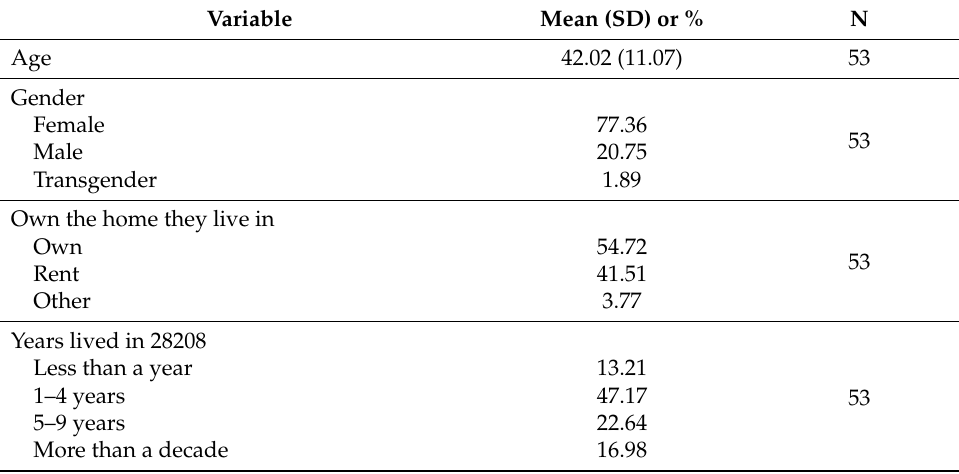
Table 2. Respondents’ Background